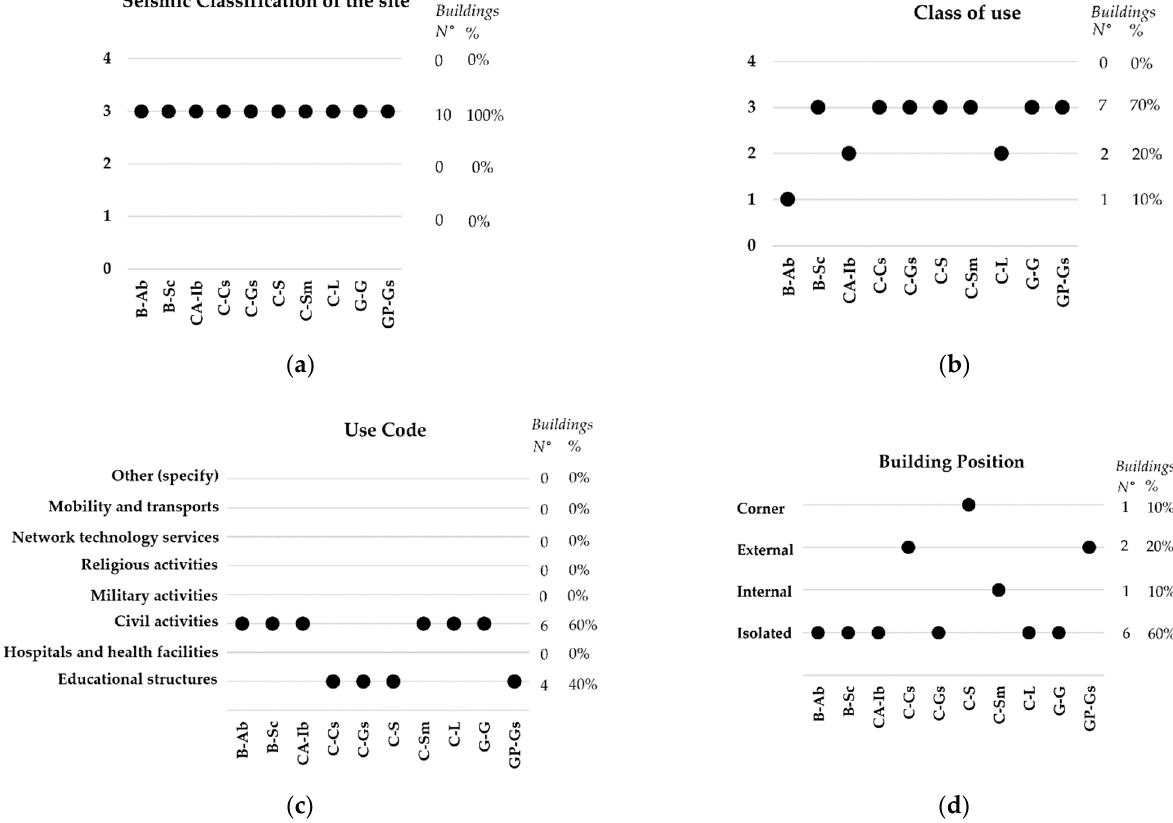
Figure 8. Section 0 CARTIS-Building. Location and Building Identification Data: ( a ) Seismic classification of the site; ( b ) Class of use of the building; ( c ) Use code of the building; and ( d ) Building position.